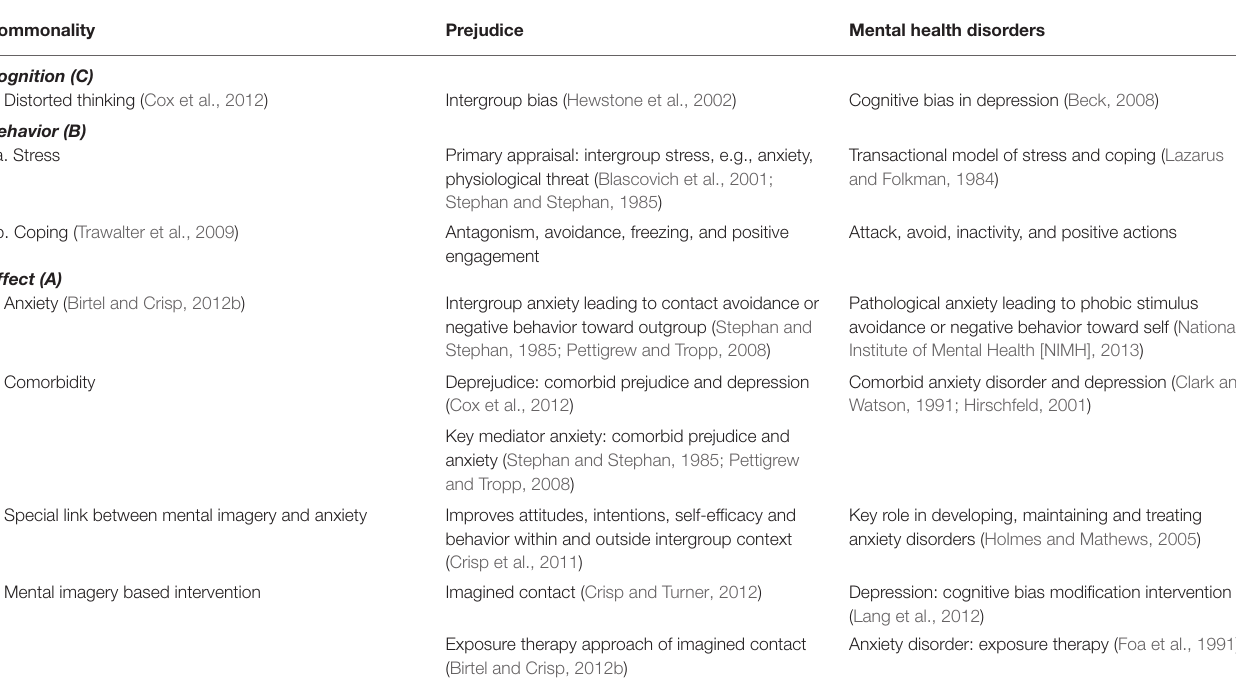
TABLE 1 | Examples of commonalities in prejudice and mental health disorders